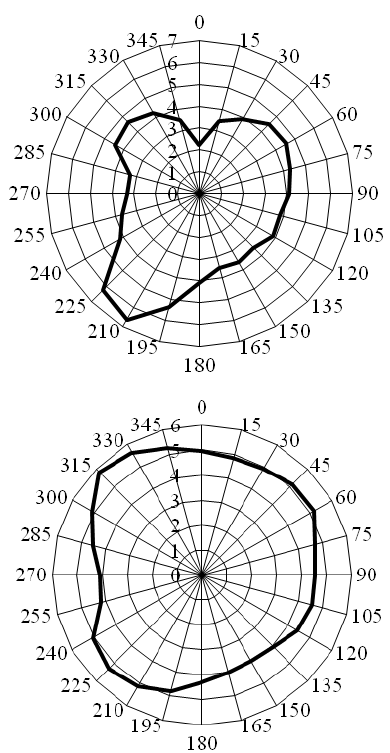
Fig. 3. Wind frequency rose (a) and wind speed rose (b) derived from radiosonde data in the North China Plain (Radiosonde data are from stations at Beijing, Fuyang, Jinan, Xuzhou and Zhengzhou) (a. Radial units are percent per 15 ◦ directional band; b. wind speed units are m s -1 ).